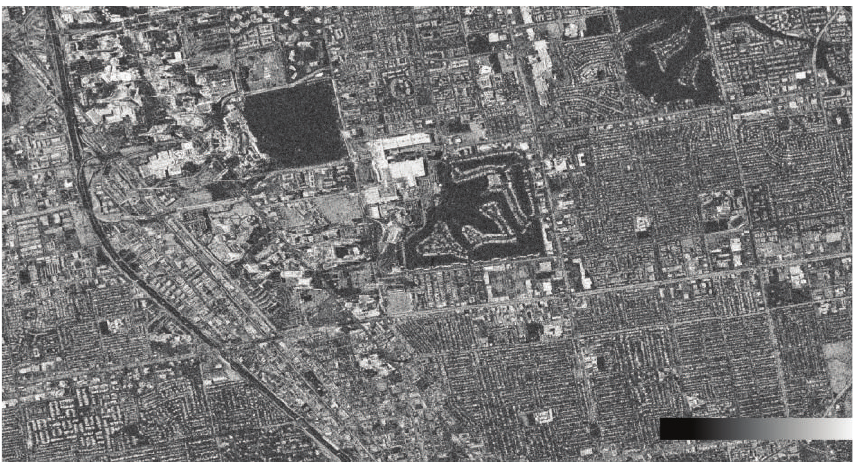
Figure 16: TerraSAR-X repeat pass coherence image. Master 2010-07-12 slave: